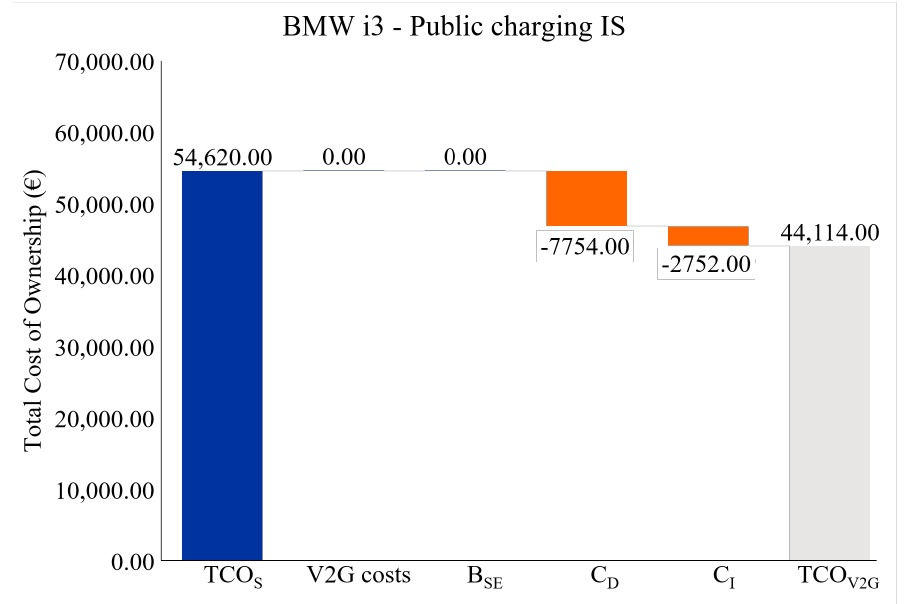
Figure A18. Standard and V2G TCO of a BMW i3 in a public charging case providing IS ( TCO S = Standard TCO, B SE = benefit of saved electricity costs from the grid, C D = direct com- pensation, C I = indirect compensation, TCO V 2 G = V2G TCO); source: own